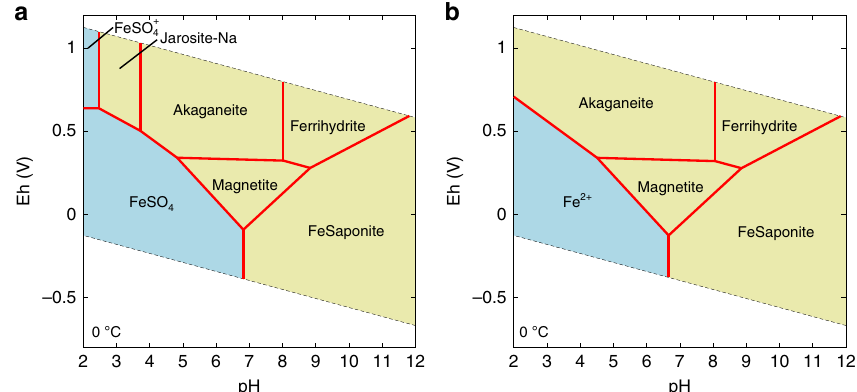
Fig. 4 Eh-pH diagram of relevant iron species for the pore-water composition of the full-interaction scenario ( a ) and the no-interaction scenario ( b ) at 0 °C and 1 atm assuming equilibrium with albite and amorphous silica. The mean water composition at Cumberland are used for the full-interaction scenario, whereas the upper limits of the concentrations are used for the no-interaction scenario NATURE COMMUNICATIONS| (2019) 10:4896